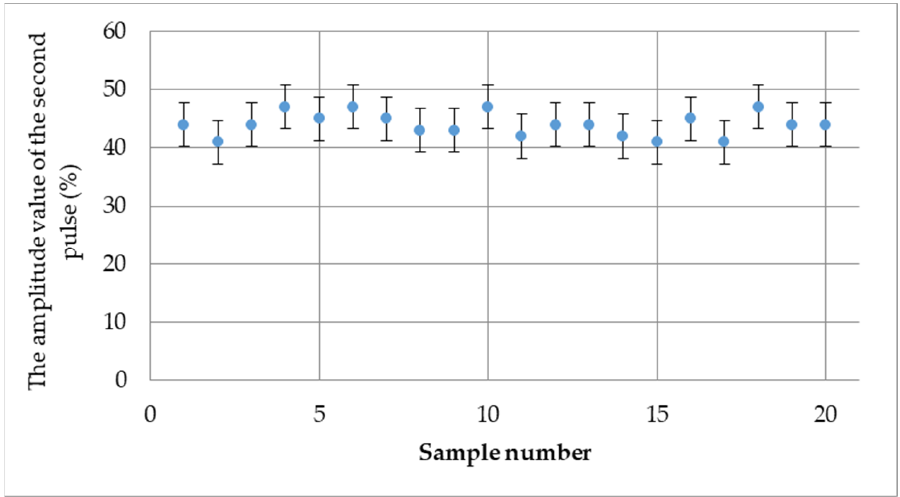
Figure 9. Average amplitude value of second pulse from the sample in % of ultrasonic flaw detec- tor screen.